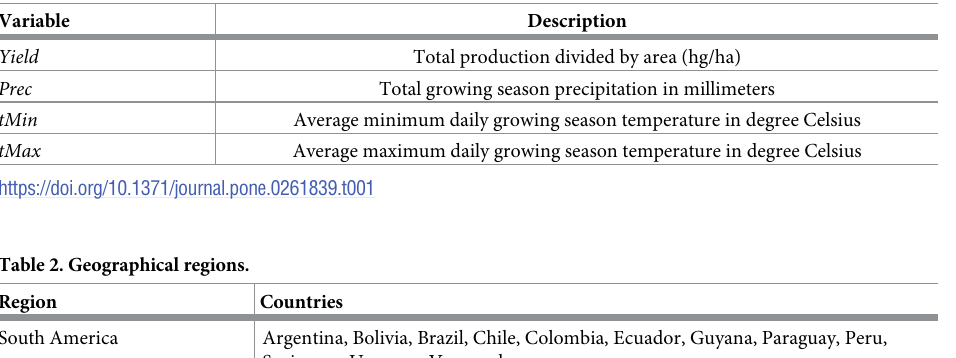
Table 1. Overview of variables.